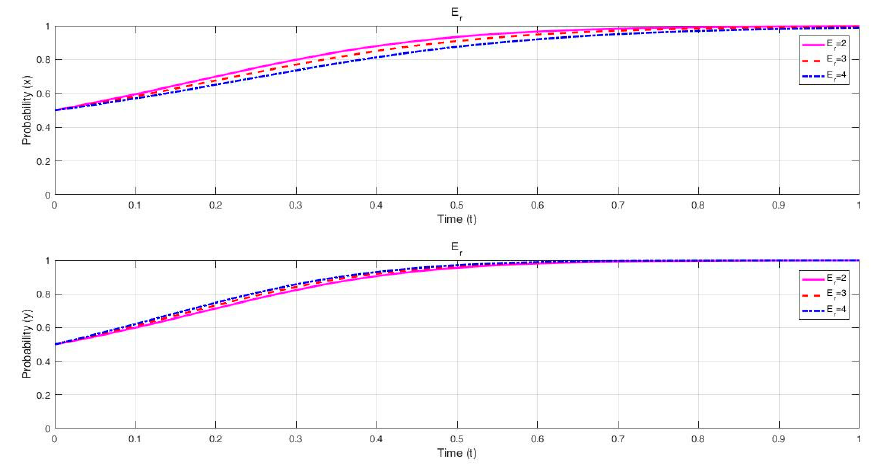
Figure 5. The impact of E r on the game.